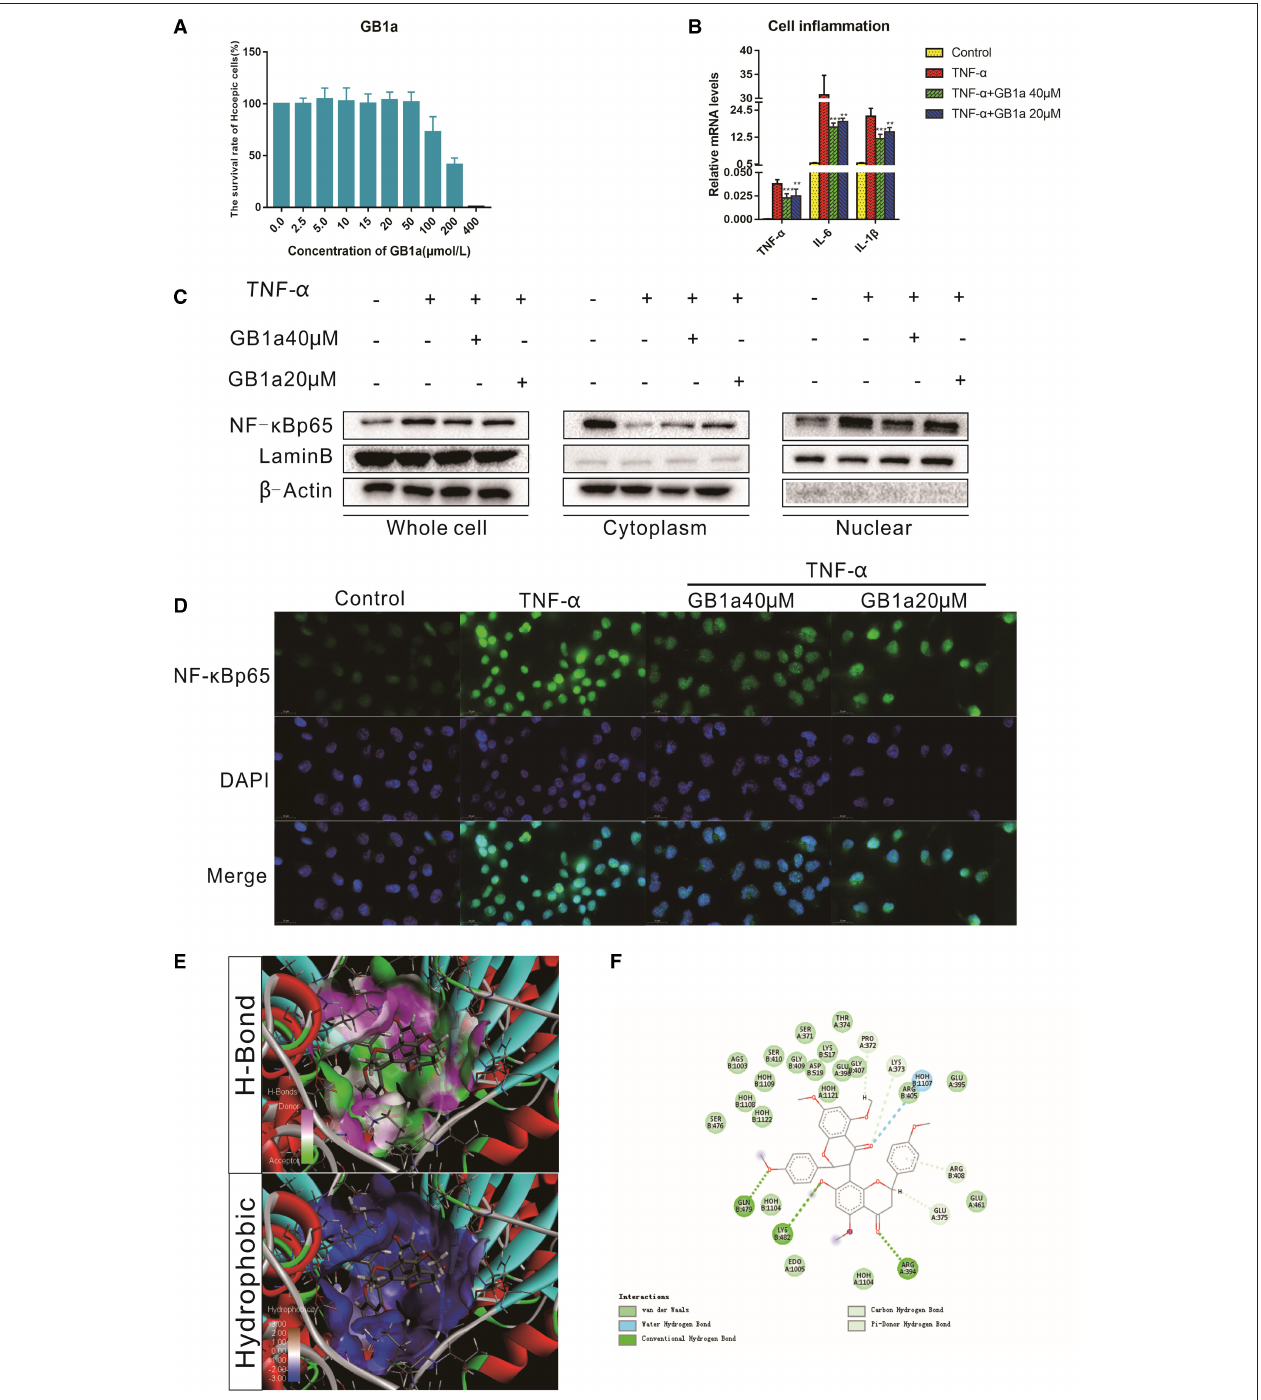
FIGURE 1 | The anti-inflammatory effects of GB1a are mediated by inhibition of NF- κ B nuclear translocation in vitro (A) CCK8 analysis showed the cytotoxicity of GB1a on HCoEpic at different doses. (B) GB1a administration reduced the expression of intracellular pro-inflammatory cytokines (TNF- α , IL-6 and IL-1 β ) in TNF- α -incubated HCoEpic in a dose-dependent manner. (C) GB1a treatment could inhibit NF- κ B p65 protein expression in the nucleus and block NF- κ B p65 translocation to the nucleus. (D) Immunofluorescence analysis of NF- κ B (green) in HCoEpic. DAPI was used for nuclear staining (blue). (E) The 2D structure of the predicted binding of GB1a to NF- κ B. (F) The molecular docking model of GB1a and NF- κ B. Data are presented as means ± SD ( n = 5/group). ** p < 0.01 and *** p < 0.001.vs the TNF- α -incubated group.